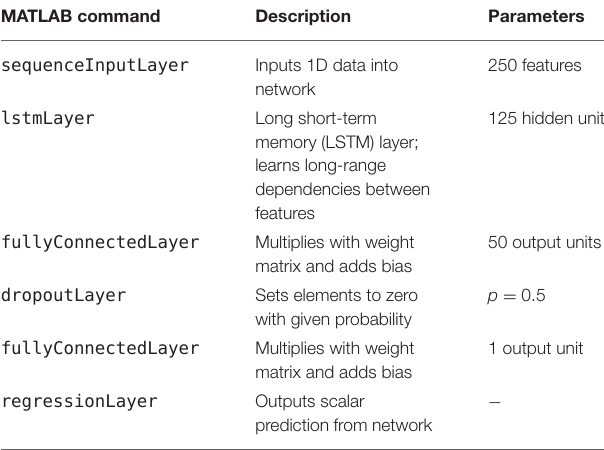
TABLE 2 | Layers of the deep neural